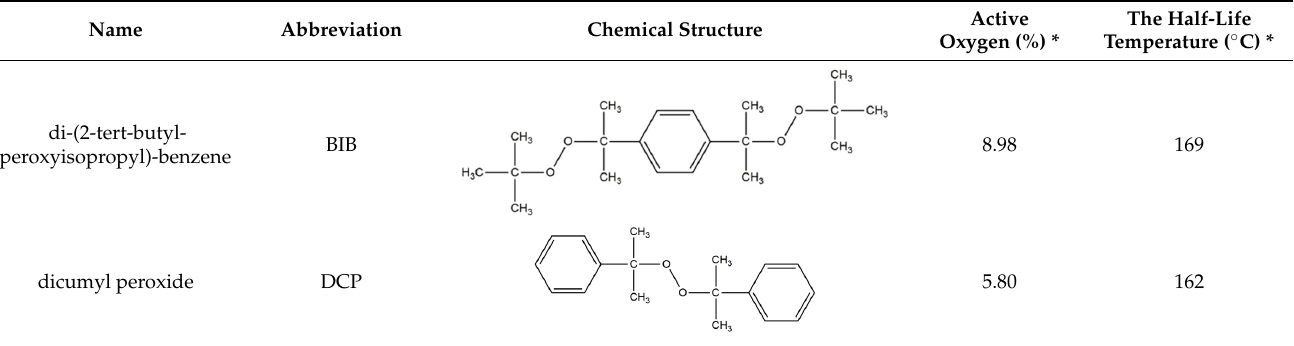
Table 1. Characteristics of used organic peroxides.